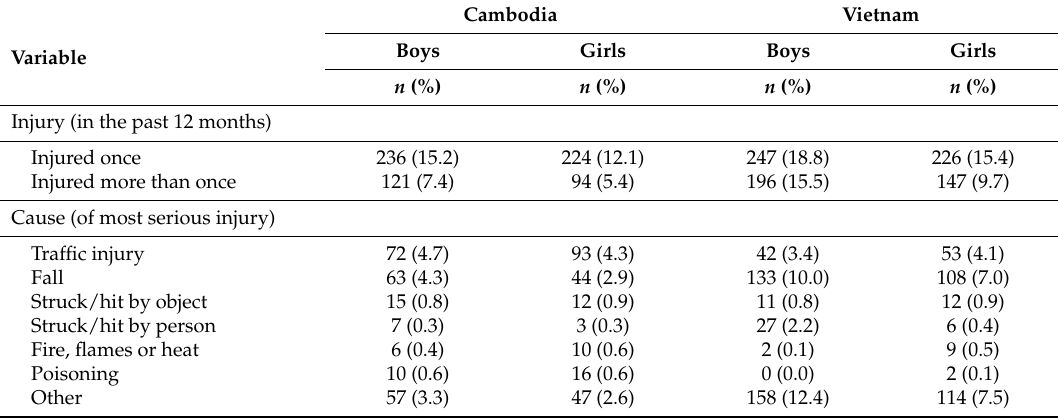
Table 3. Annual prevalence of injury events, cause and type of injury by gender in Cambodia and